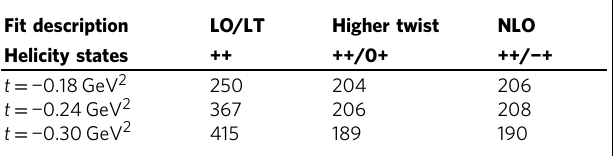
Table 2 Results of the cross-section fi ts